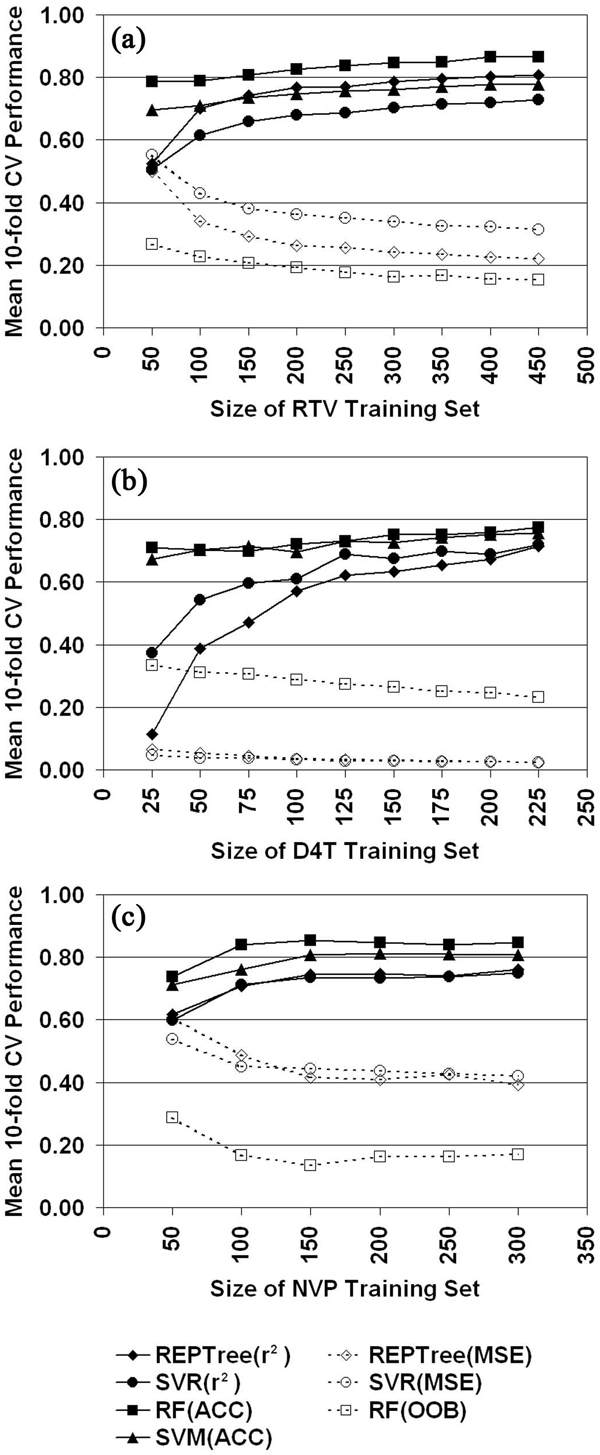
Relating dataset size to model performance. Learning curves plotted for (a) ritonavir (RTV), (b) stavudine (d4T), and (c) nevirapine (NVP) using their respective TSM attribute mutant datasets (ACC, overall accuracy).